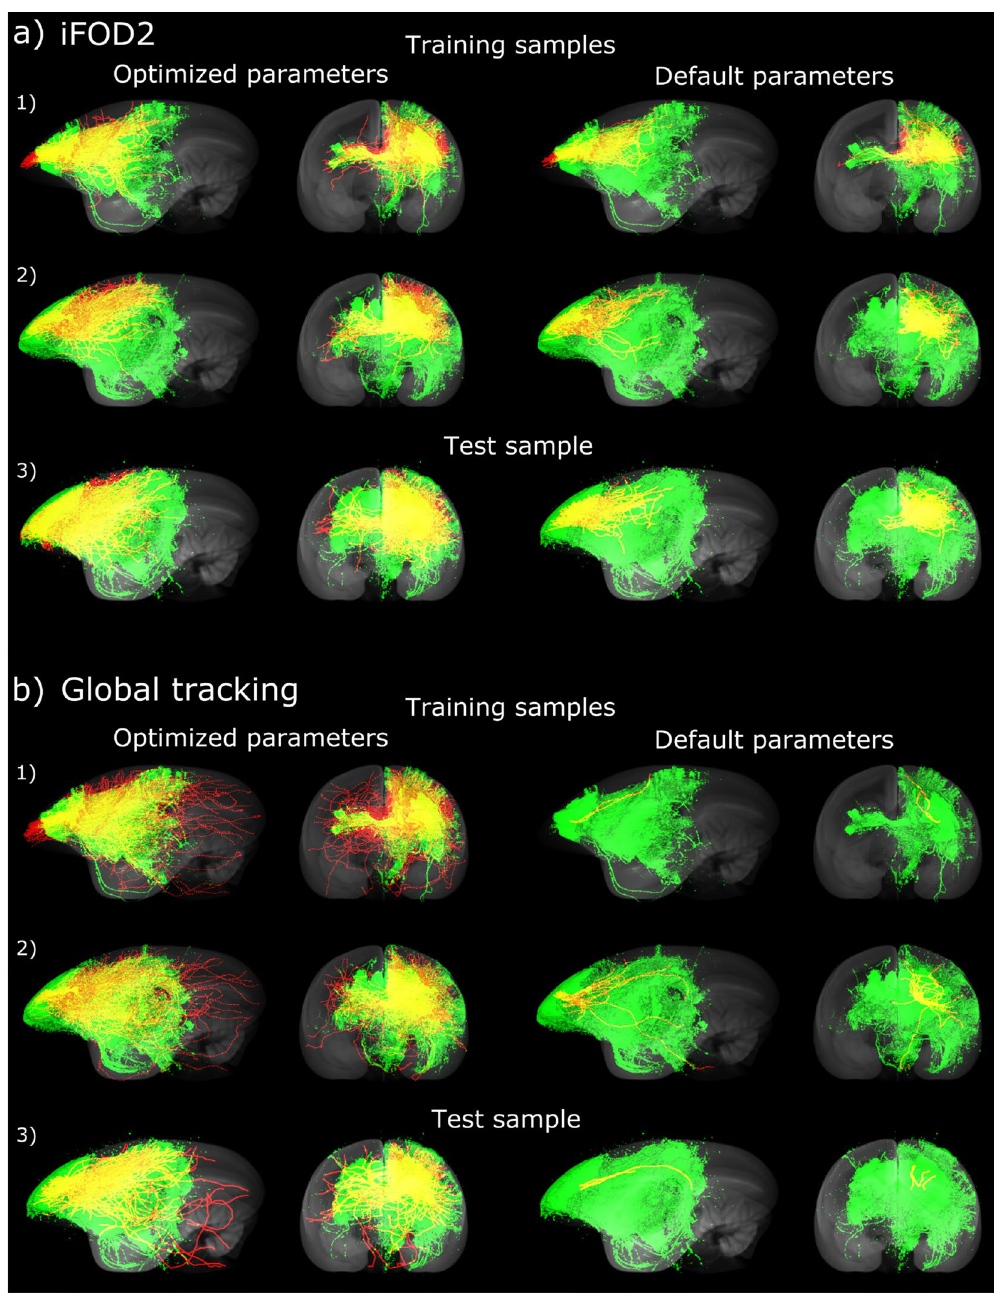
Figure 3. Examples of tracked fibers by optimized and default parameters. Unoccluded visualization of spatial relationships between fluorescent tracer signals (green) and tractography (red) for 3 injection sites: (1, 2) from the training set; (3) from unseen marmoset subjects. Their overlap (yellow) shows common voxels, while red fibers correspond to “false positives”. Improved results for both, ( a ) iFOD2 and ( b ) global tracking algorithms, show enlarged overlap and longer fibers connecting sub-cortical and projection areas. Figure created using FluoRender 2.24 (https ://www.sci.utah.edu/softw are/fluor ender .html) and Inkscape 1.0beta2 (https ://inksc ape. org/). Image datasets are part of the Brain/MINDS project (see Data availability